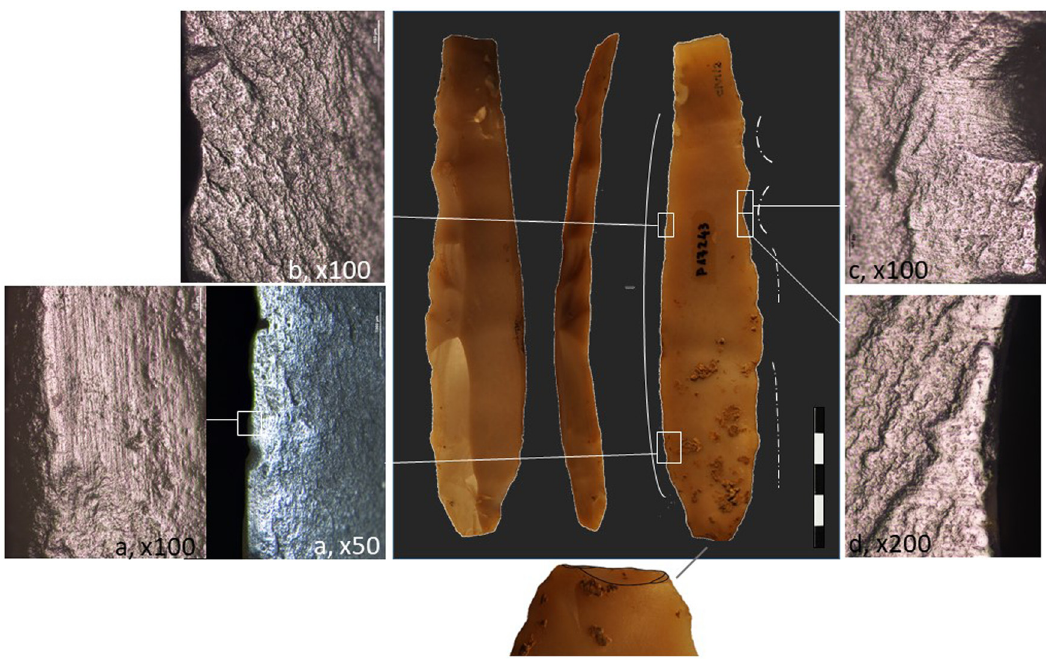
Figure 3: Crested Blade with one fl at versant, obtained by lever pressure, used on both edges, to cut soft mineral material ( a ) and vegetal material ( b ) , to scrape abrasive material ( c ) and wood ( d ) .